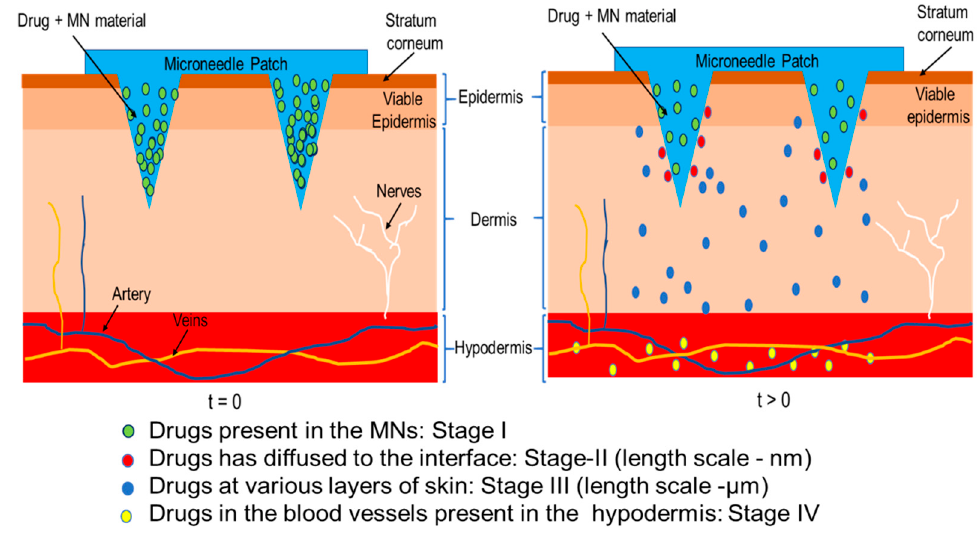
Figure 2. Schematic of drug transport in MN treated skin.